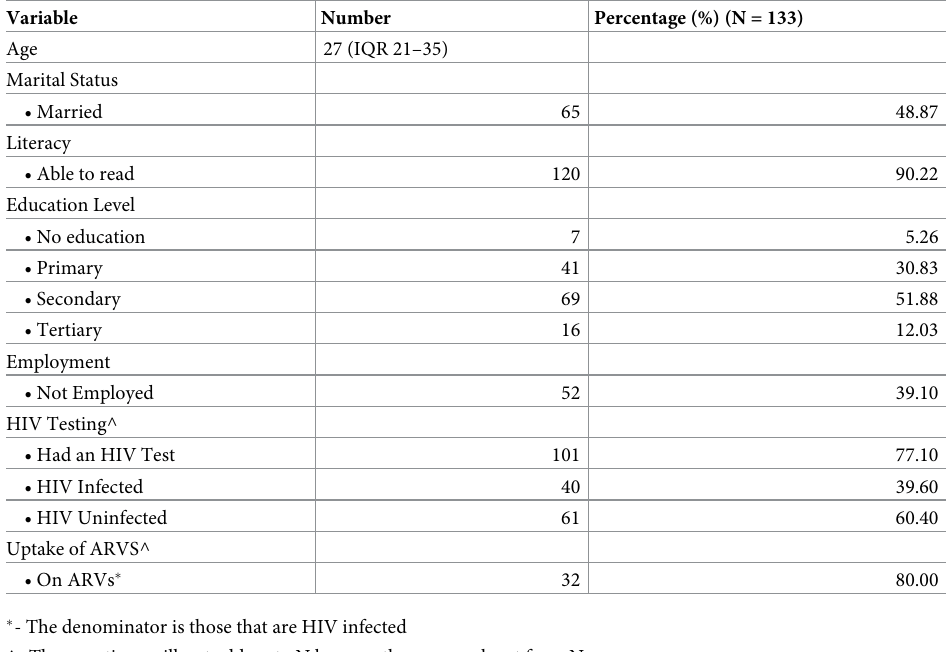
Table 1. Characteristics of men that were involved in the study.